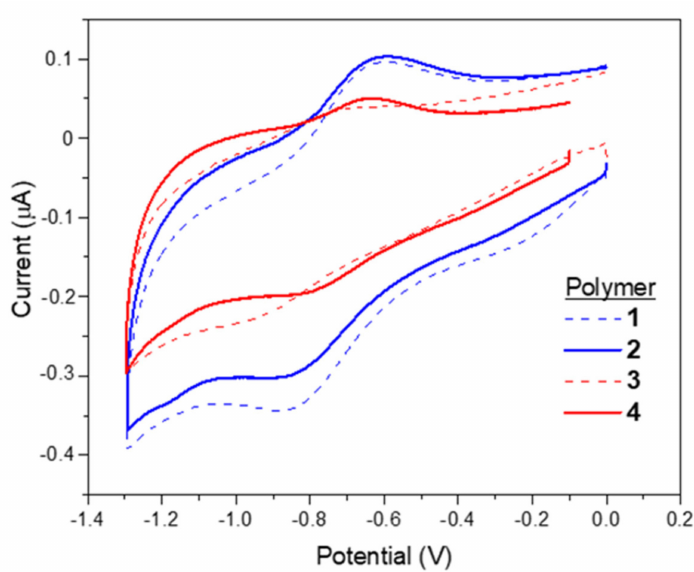
Figure 7. Cyclic voltammograms of redox system of polymers 1–4 in about 0.1 M NaClO 4 /DMSO supporting electrolyte at scan rate 100 mV s − 1 .